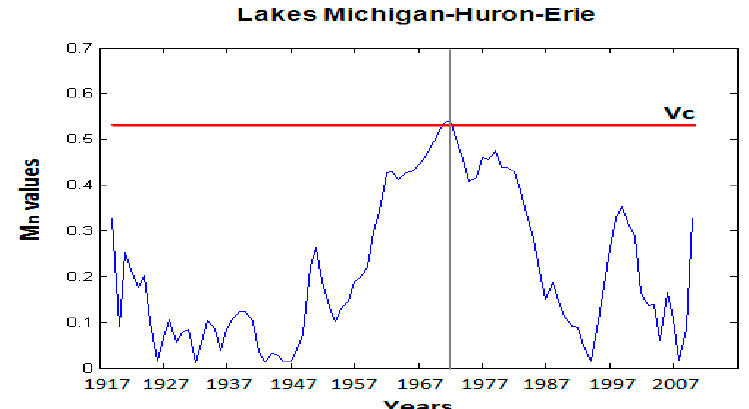
Figure 7. Analysis of dependence using the copula method. Temporal variability of M n values derived for monthly mean minimum water level series for Lakes Michigan ‐ Huron and Erie (1918–2012). The horizontal red line shows the critical value of V c . The vertical line represents the timing of the change of dependence between the water levels.